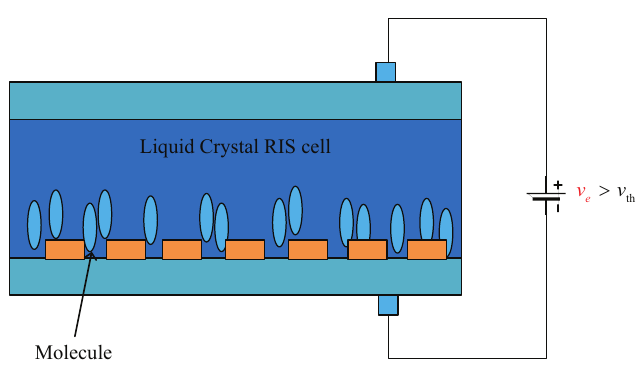
Figure 3. The molecular orientation of the LC RIS before applying the voltage.